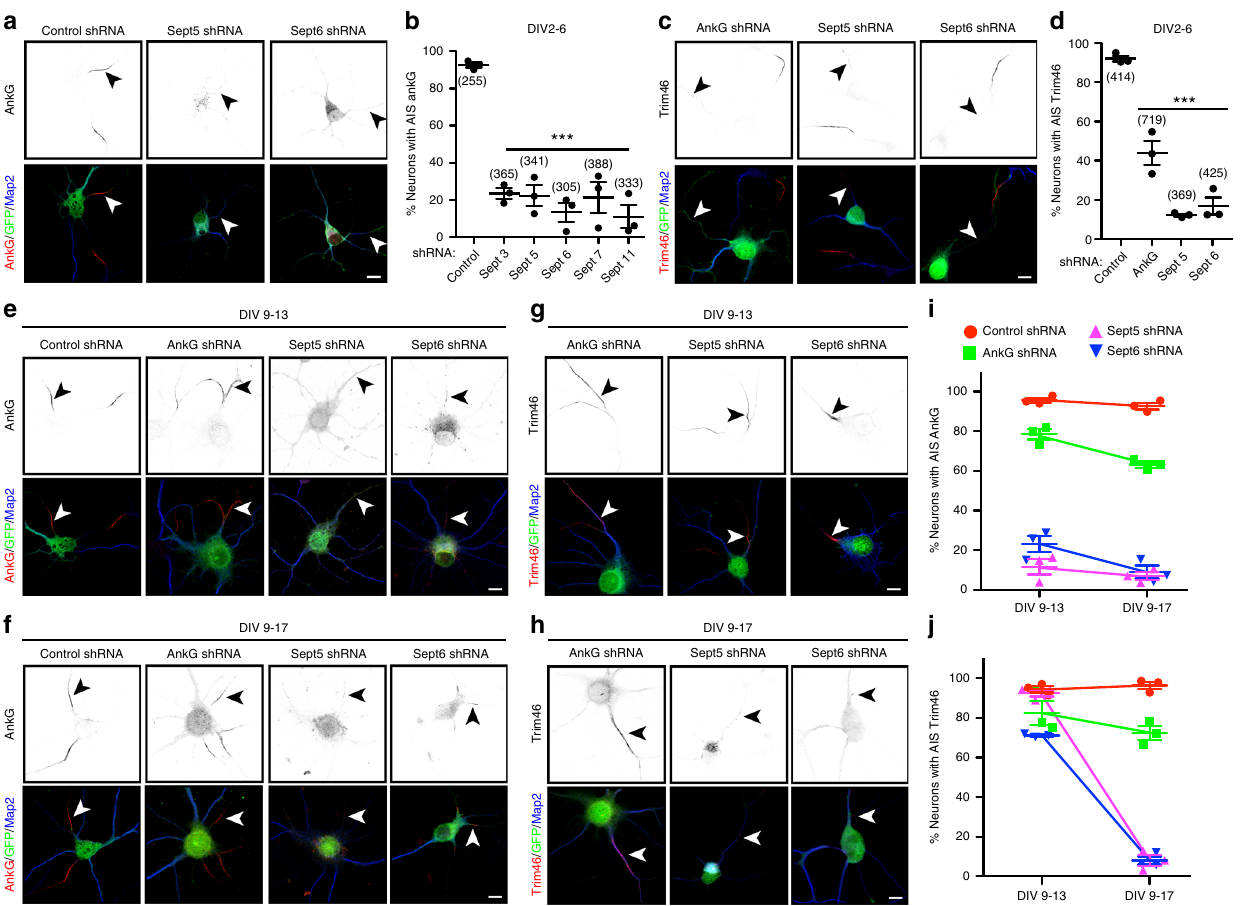
Fig. 6 Septins stabilize and maintain AnkG at the AIS. a , c Immunostaining of DIV6 neurons, transfected at DIV2 with control, Sept5, and Sept6 shRNAs, using antibodies against AnkG ( a , red) or Trim46 ( c , red), GFP (green), and Map2 (blue). Arrowheads indicate AIS. In c each fi eld also shows AIS of untransfected neurons. b Percentage of neurons with AIS AnkG. DIV2 neurons transfected using shRNAs against Luciferase (Luc), and Septins 3, 5, 6, 7, and 11. Neurons were immunostained for AnkG immunoreactivity at DIV6. ( F = 31.54, df total = 17) *** p = 1.66 × 10 − 6 ; one-way ANOVA. n = 3 independent experiments, total neurons: Luc shRNA = 255, Sept3 shRNA = 365, Sept5 shRNA = 341, Sept6 shRNA = 305, Sept7 shRNA = 388, Sept11 shRNA = 333. d Percentage of neurons with AIS Trim46. DIV2 neurons transfected using shRNAs against Luc, AnkG, Sept5, and Sept6. Neurons were immunostained for Trim46 immunoreactivity at DIV6. ( F = 88.68, df total = 11) *** p = 1.76 × 10 − 6 ; one-way ANOVA. n = 3 independent experiments, total neurons: Luc shRNA = 414, AnkG shRNA = 719, Sept5 shRNA = 369, Sept6 shRNA = 425. e , f Immunostaining of DIV13 ( e ) and DIV 17 ( f ) neurons, transfected at DIV9 with control, AnkG, Sept5, and Sept6 shRNAs, using antibodies against AnkG (red), GFP (green), and Map2 (blue). Arrowheads indicate AIS. g , h Immunostaining of DIV13 or DIV17 neurons, transfected at DIV9 with AnkG, Sept5, and Sept6 shRNAs, using antibodies against Trim46 (red), GFP (green), and Map2 (blue). Arrowheads indicate AIS of transfected neurons. i Percentage of neurons with AIS AnkG. Neurons transfected at DIV9 using shRNA to Luc, AnkG, Sept5, or Sept6. AIS were labeled for AnkG at DIV13 or DIV17. n = 3 independent experiments, total neurons: (DIV9-13) Luc shRNA = 423, AnkG shRNA = 443, Sept5 shRNA = 252, Sept6 shRNA = 455; (DIV9-17) Luc shRNA = 423, AnkG shRNA = 515, Sept5 shRNA = 312, Sept6 shRNA = 245. j Percentage of neurons with AIS Trim46. Neurons transfected at DIV9 using shRNA to silence Luc, AnkG, Sept5, or Sept6. AIS were labeled for Trim46 at DIV13 or DIV17. n = 3 independent experiments, total neurons: (DIV9-13) Luc shRNA = 454, AnkG shRNA = 544, Sept5 shRNA = 240, Sept6 shRNA = 253; (DIV9-17) Luc shRNA = 256, AnkG shRNA = 390, Sept5 shRNA = 249, Sept6 shRNA = 245. All error bars, ±SEM. All scalebars = 5 µ m. Source data are provided as a Source Data fi